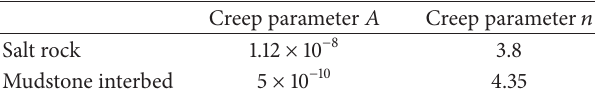
Table 1: Material creep parameters of salt rock and mudstone interbed.